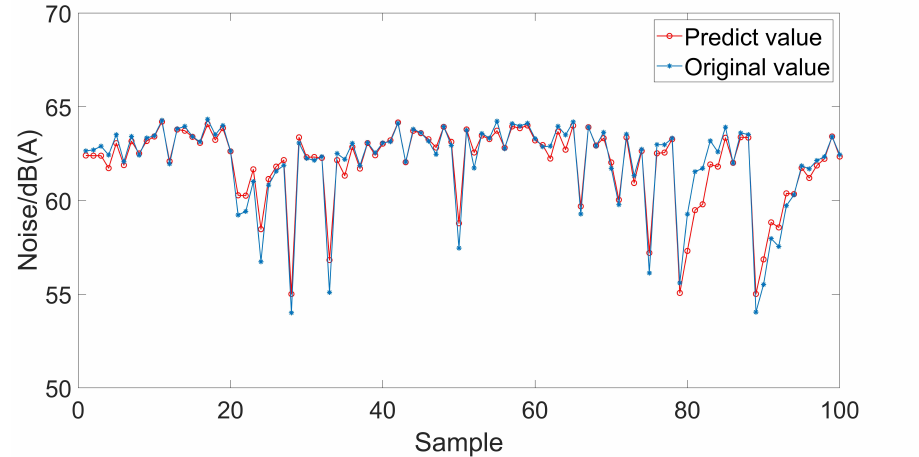
Figure 14. GRNN neural network prediction results.